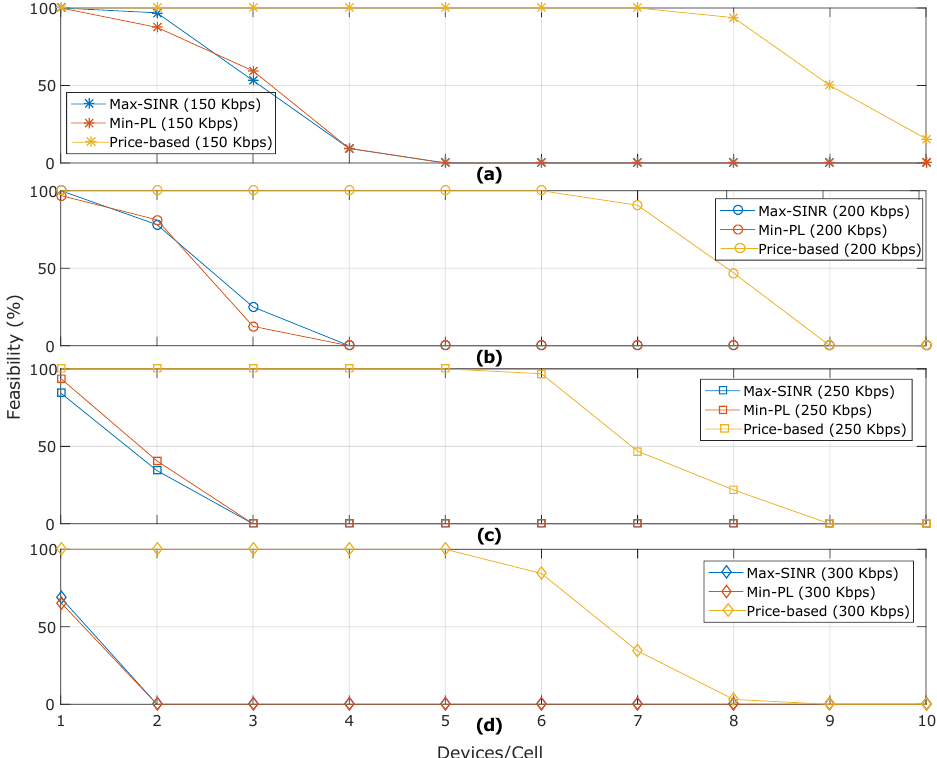
Figure 3. Feasible solutions (%) found by each algorithm under a backhaul capacity of 12 Mbps and different data rate requirements of human-type communication devices (HTC) devices: ( a ) 150 Kbps, ( b ) 200 Kbps, ( c ) 250 Kbps, and ( d ) 300